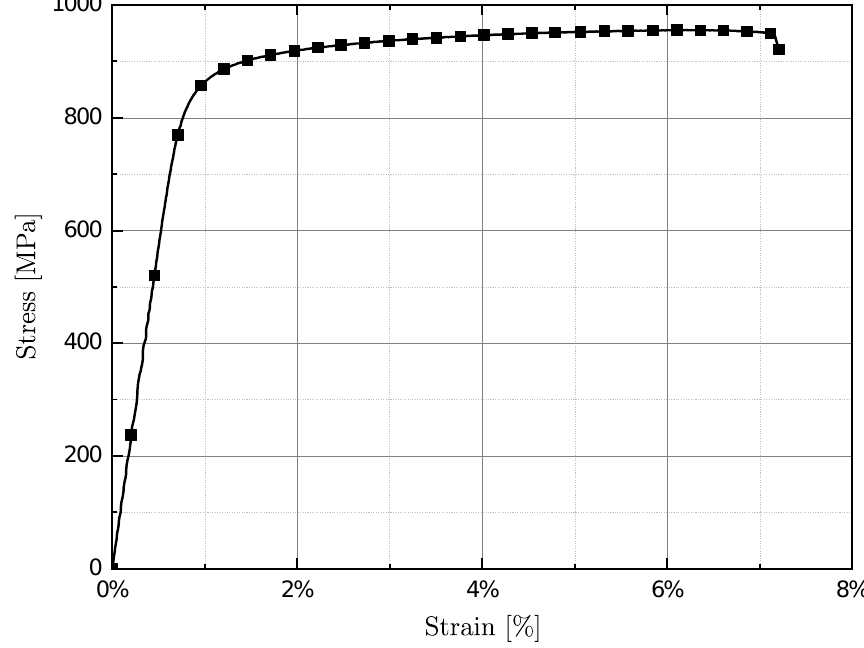
Figure 4. Representative tensile test with specimen extracted in horizontal direction. Table 3. Summarized mechanical properties of tensile tests extracted in horizontal directions.